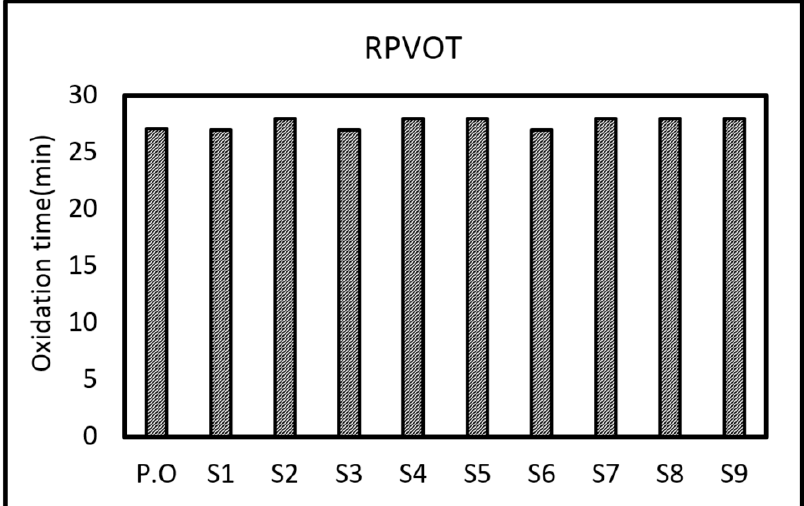
Figure 5. Rotating pressure vessel oxidation test (RPVOT) anti-oxidation test.